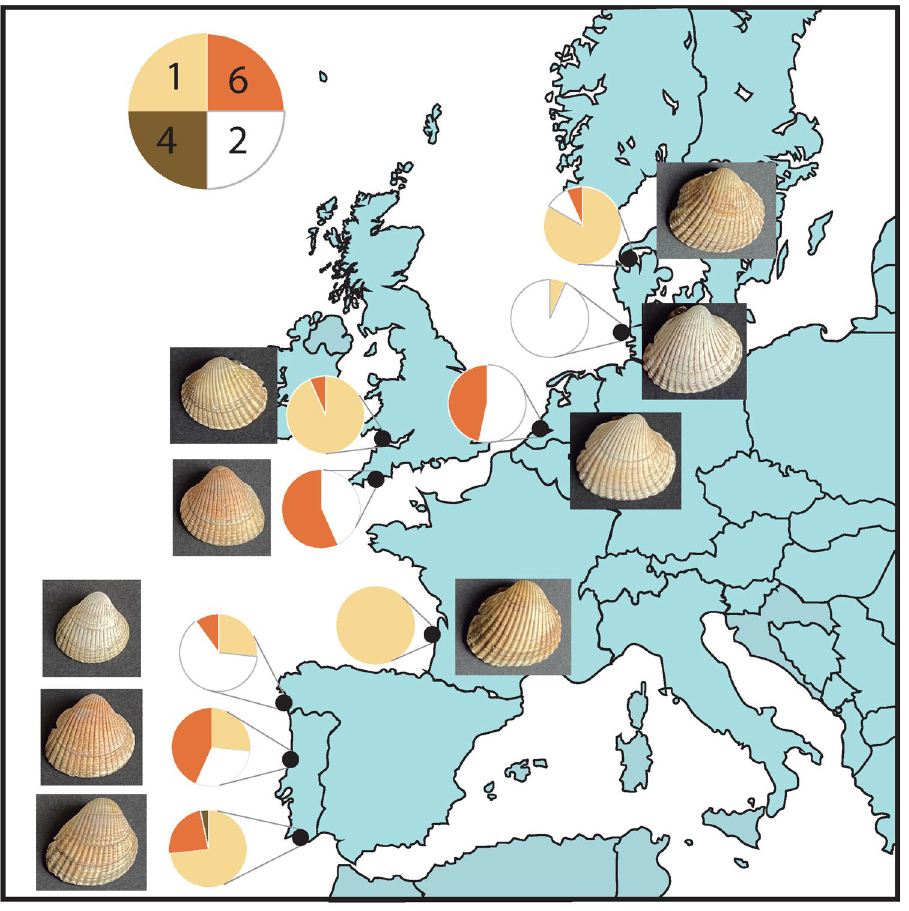
Figure 2. Geographical representation of the European samples of C. edule , including pie chart color distributions (yellow (1), white (2), brown (4), orange (6)) and a photograph of a representative individual. From north to south: Nykobing Mors (Denmark), Sylt (Germany), Slikken van Viane (Netherlands), Wales and Plymouth (United Kingdom), Arcachon (France), Baiona (Spain), Aveiro and Algarve